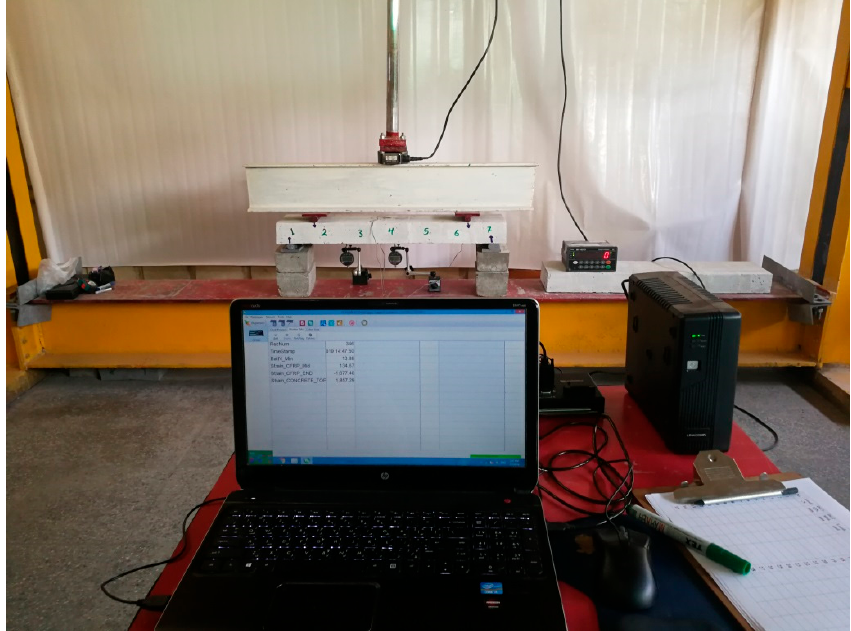
Figure 7. Typical test arrangements of segmental beams specimen.